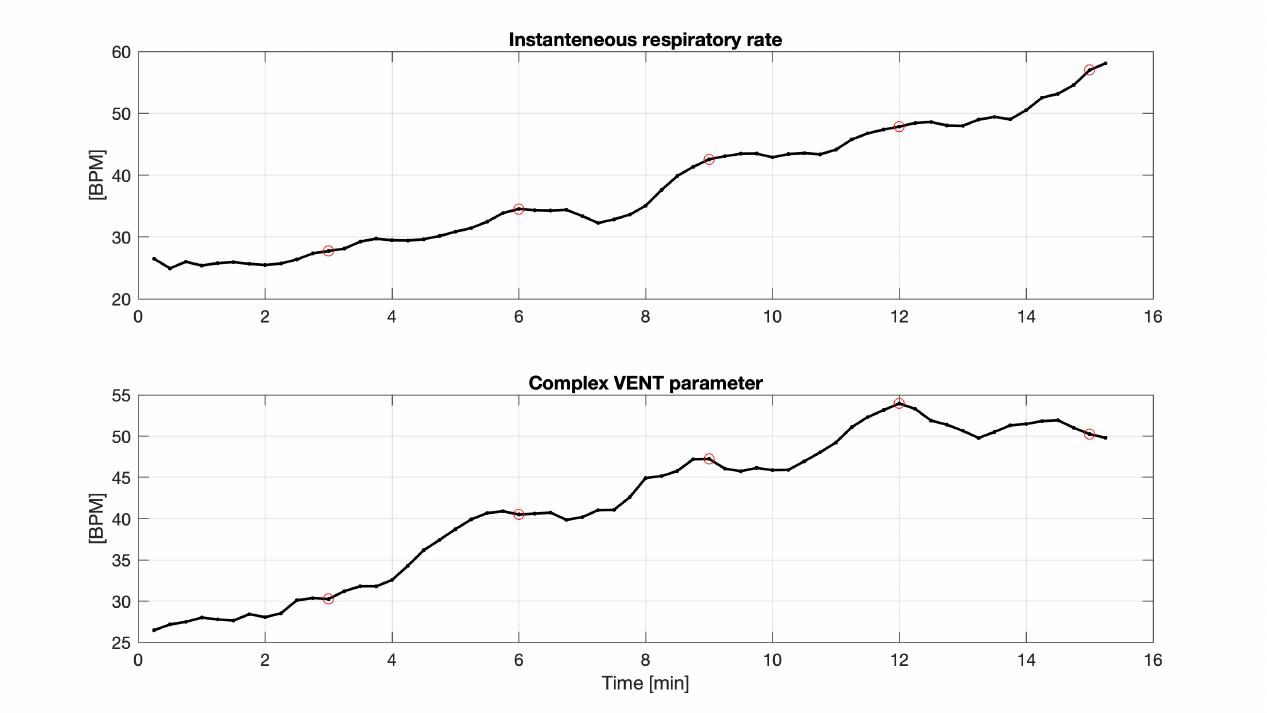
Figure 3. Sample courses of respiratory rate and complex VENT parameter for IP signal acquired for the 34th subject.